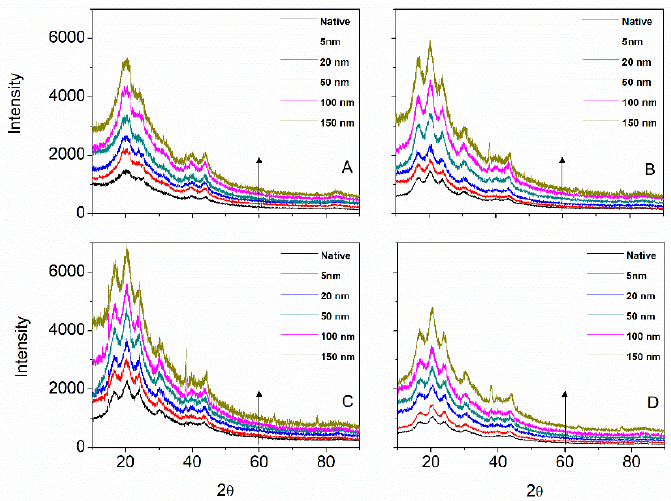
Figure 5. X-ray diffractogram as a function of gold NP size for Mulberry ( A ), Eri ( B ), Muga ( C ), and Tasar ( D ) silks. The arrow indicates an increasing gold NP size. Note at around 37 ◦ the (111) reflection for the gold.